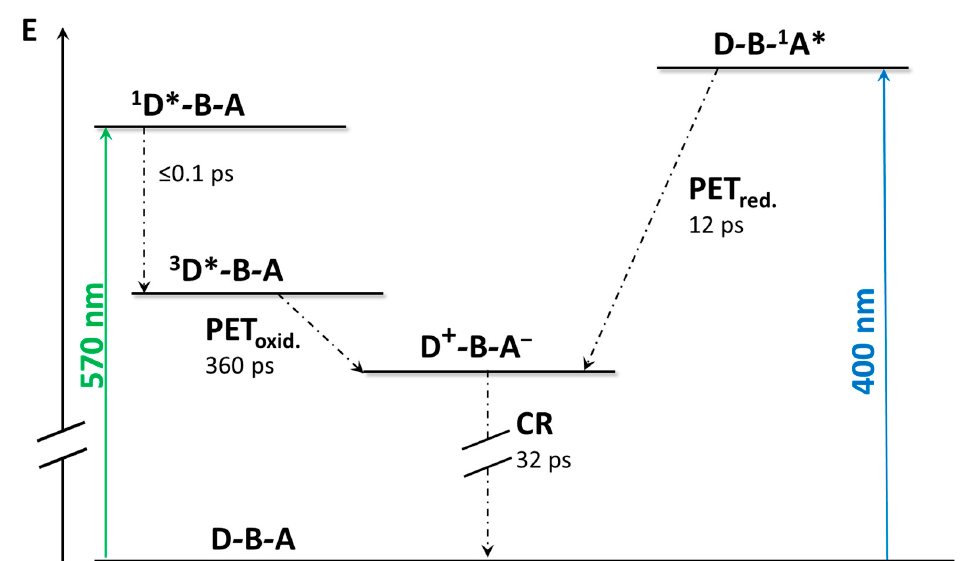
Figure 7. Schematization of the excited-state decay of 3 .